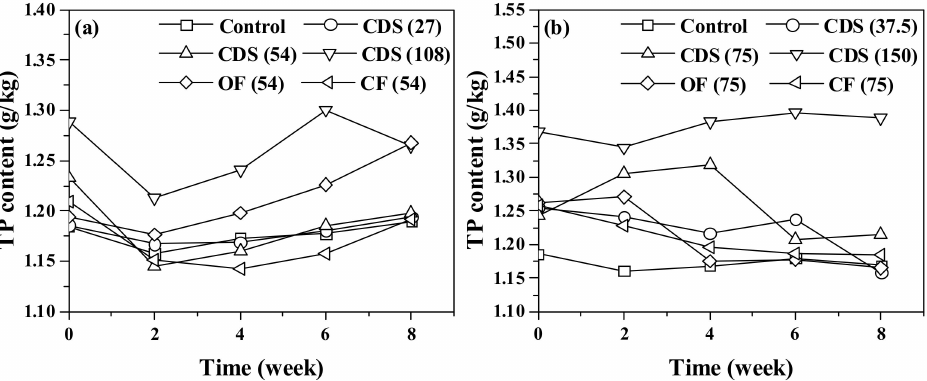
Figure 4. TP in soil affected by application of co-digestion sludge (( a ): phase one, ( b ): phase